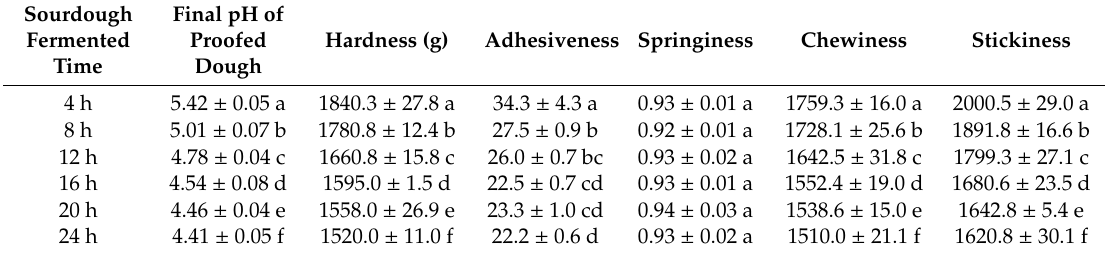
Table 1. Effect of sourdough fermented time on the texture of Chinese northern steamed bread. Sourdough